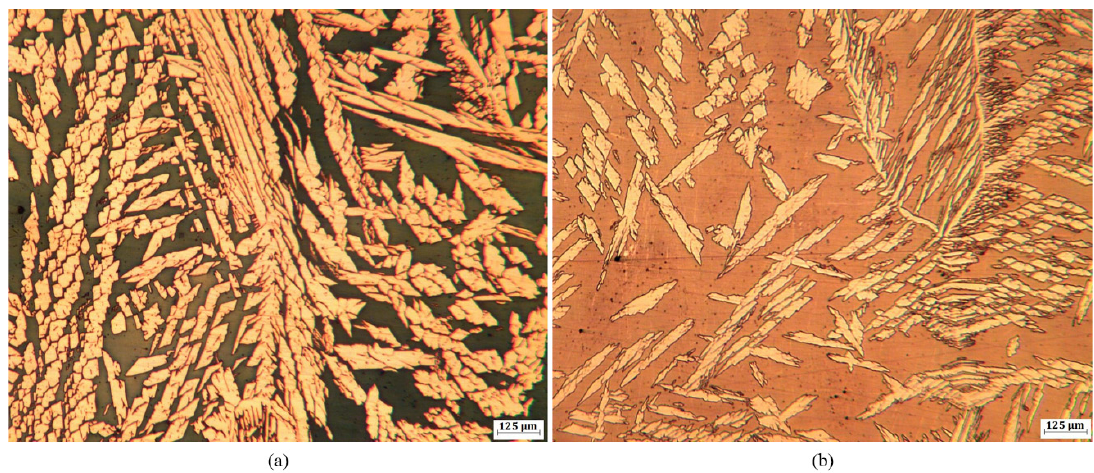
Figure 19. Microstructure from the 2205 DSS FZ: (a) shielding gas A (b) shielding gas B. (1.6 kJ mm –1 .